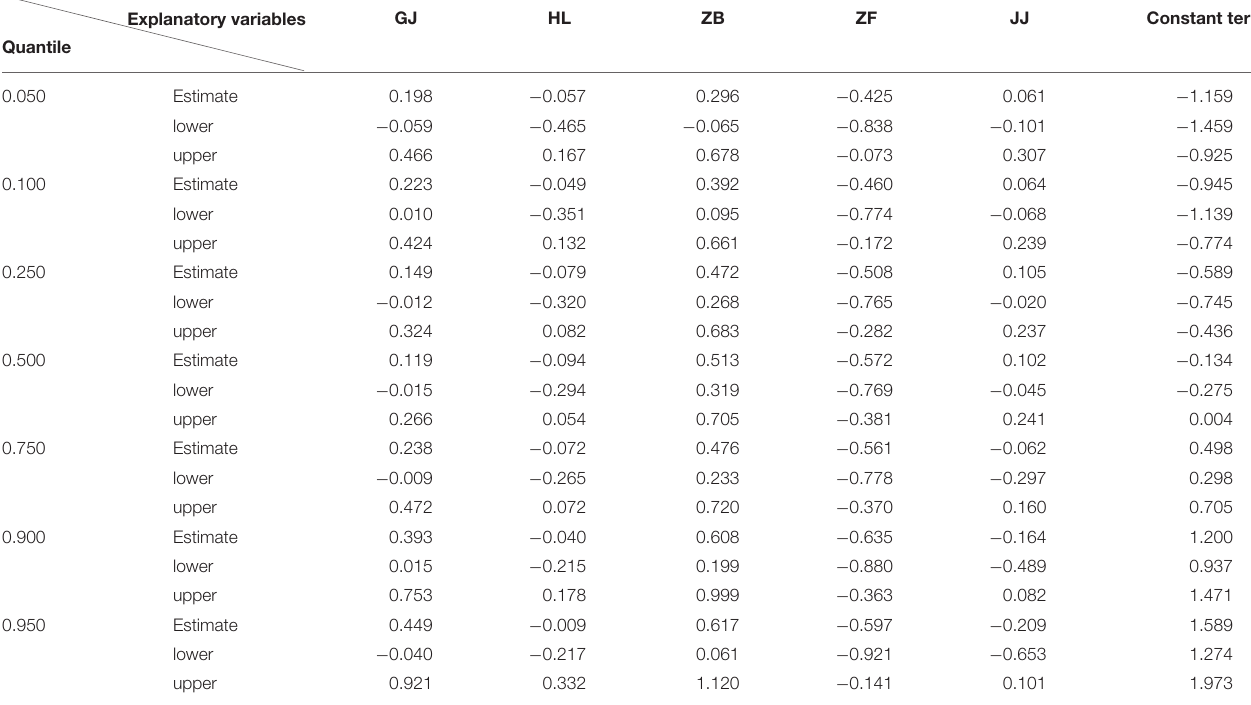
TABLE 10 | Bayesian quantile regression results (ndraw =